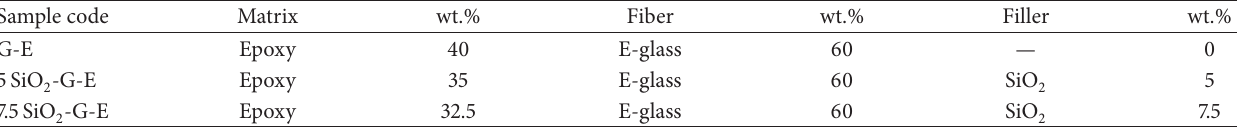
Table 2: Fabricated